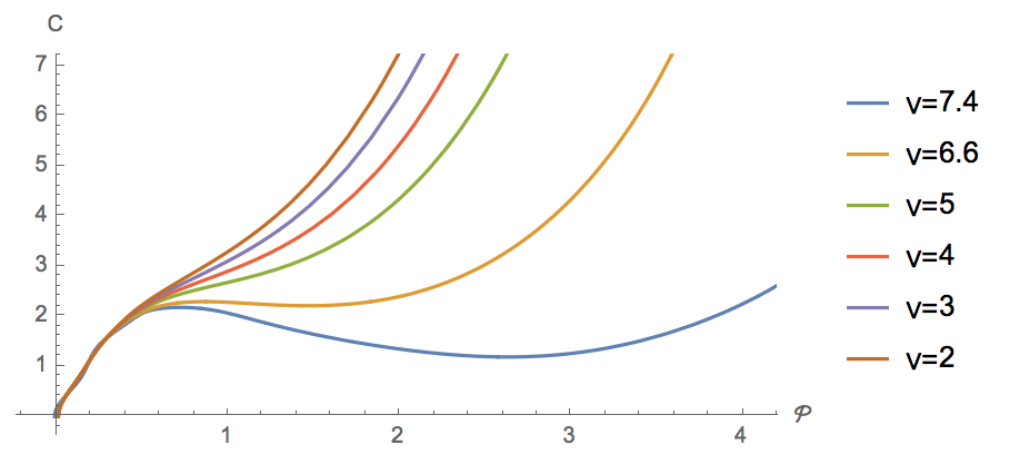
Figure 21 . Horizon geometry as function of the proper distance P for (cid:12)xed (cid:22) = 14 : 5. Increasing the parameter (cid:23) leads to a globule with a longer neck on the horizon in the